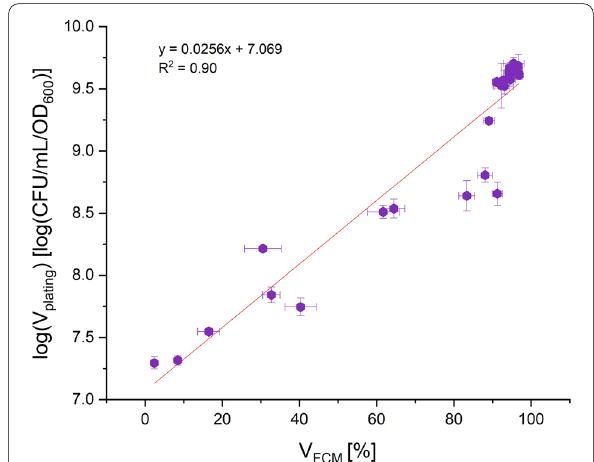
Fig. 4 Logarithmic trend of V FCM [%] versus log (V plating ) with a correlation factor of R 2 =